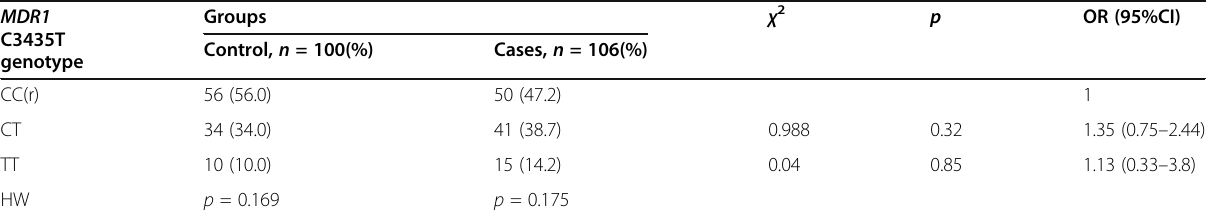
Table 2 Distribution of MDR1 C3435T SNP genotype among the studied groups MDR1 C3435T genotype